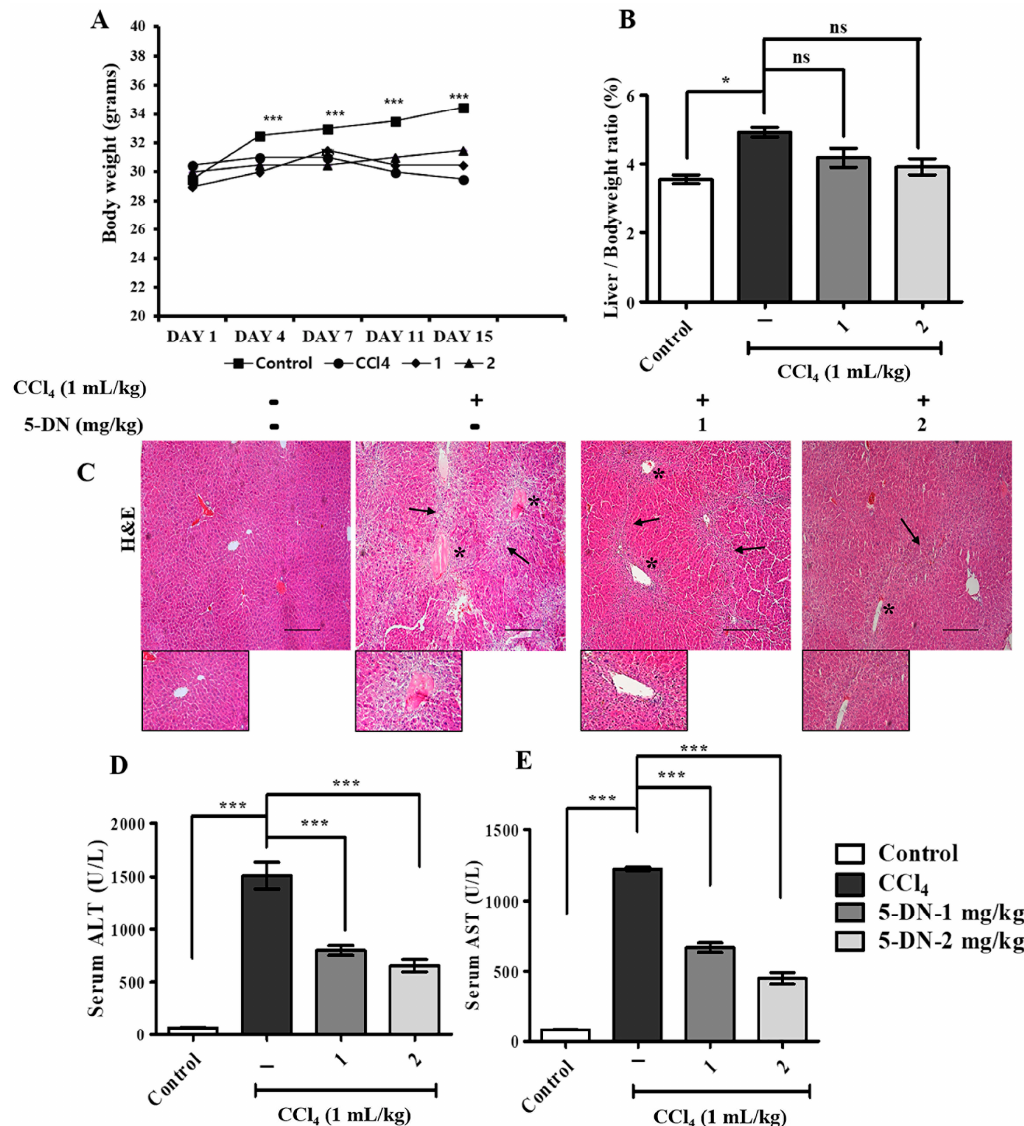
Figure 2. 5-DN attenuated CCl 4 -induced severe hepatic damage in BALB/c mice (mice, n = 6/group). ( A ) Assessment of the body weight from different mice groups over a period of 15 days. ( B ) Liver weight/ body weight ratio in percentage of different mice groups. ( C ) H&E staining on liver tissues. Asterisk (*): represents the regenerative nodules, Arrow ( → ): represents the fibrous septa extending from the veins, and zoomed images represent infiltration of inflammatory cells from central veins. ( D ) Serum ALT analysis. ( E ) Serum AST analysis. Magnification: 200 × , Scale bar (100 µ M). Images were captured using Olympus BX51 fluorescence microscope. The data are represented here are the mean ± S.D. from three independent experiments where * p < 0.05, *** p < 0.001, Control vs. CCl 4 , CCl 4 vs. 5–DN (1–2 mg/kg). Statistical significance analysis was carried out through one-way analysis of variance (ANOVA)